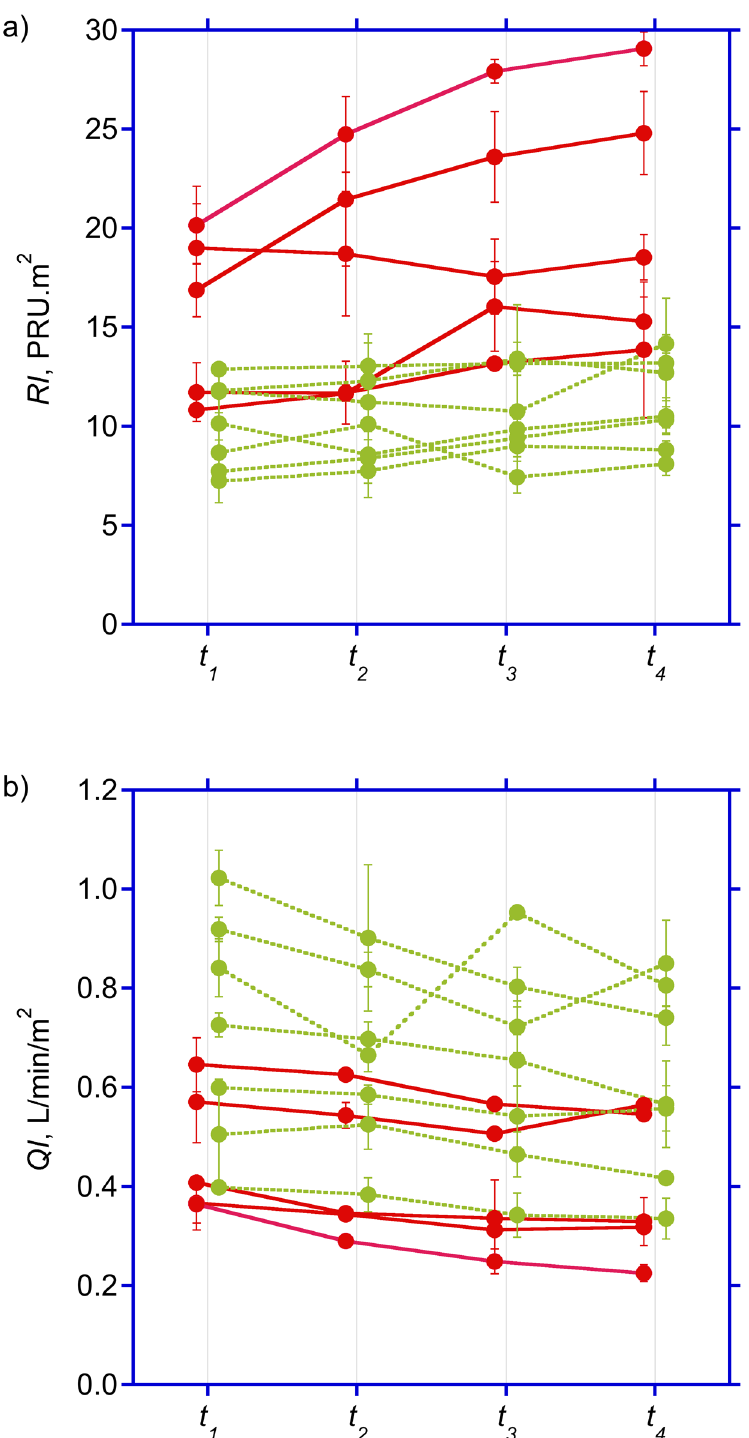
Fig 2. Time course of hepato-splanchnic hemodynamics. Time course of splanchnic vascular resistance index ( RI ) (top panel) and hepato-splanchnic perfusion index ( QI ) (bottom panel) measured at times t 1 through t 4 during dialysis in diabetic (red symbols) and non-diabetic (green symbols) subjects. Symbols represent average values ± standard deviations of duplicate measurements obtained in treatments separated by one week. For clarity, symbols for diabetics and non-diabetics are placed with a small left or right offset from the actual measuring times.